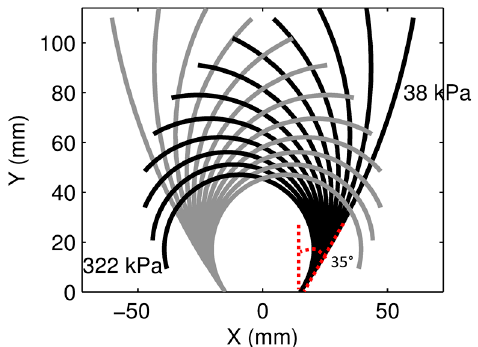
Figure 7. Two 120 mm facing fingers, traced for pressures ranging from 38 kPa to 322 kPa. Only the inside surfaces of the fingers are traced for clarity (large gripper). The initial angle of the finger with the vertical is shown (35°).